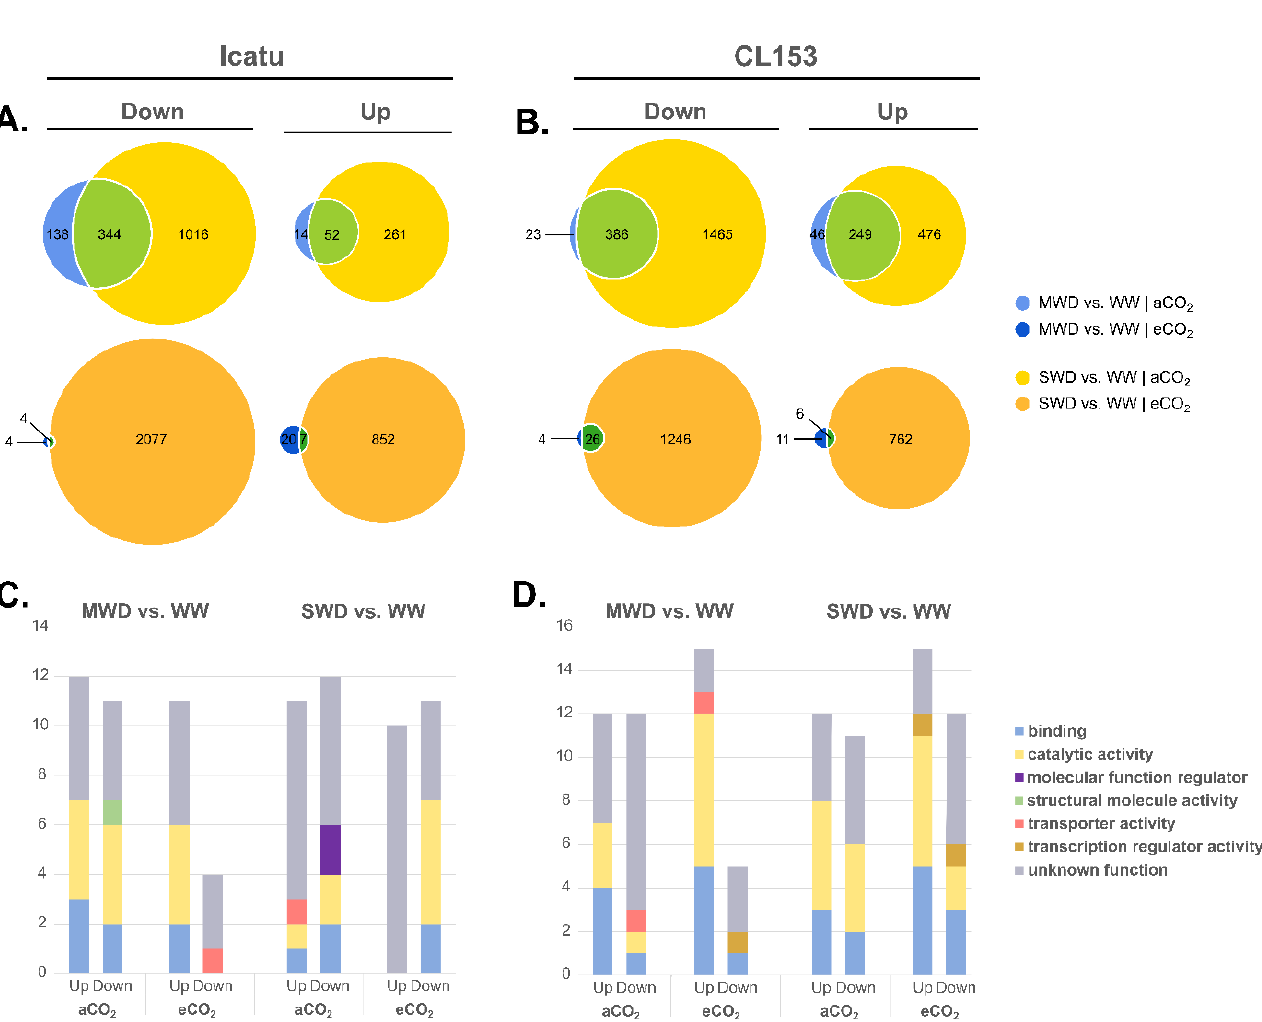
Figure 2. Patterns of differentially expressed genes (DEGs) at MWD or SWD in comparison with WW in ( A ) Icatu and ( B ) CL153 plants grown under either aCO 2 (light colors) or eCO 2 (dark colors), at 25/20 °C (day/night). Blue: DEGs specifically found under MWD. Yellow: DEGs specifically found under SWD. Green: DEGs expressed by both water conditions. Gene ontology (GO) terms found among the top up- and down-regulated differentially expressed genes (DEGs) in ( C ) Icatu and ( D ) CL153 plants. GO terms were selected according to UniProtKB and QuickGO databases. The harshest drought level triggered a high down-regulation of DEGs, in the two genotypes, independently of [CO 2 ] levels (Figure 2A,B; Table S3). The strong impact of the SWD was also depicted on heatmaps visualizing the expression profile of all significant DEGs, where a high degree of variation was found under this harsher drought level in contrast with MWD, which promoted only minor effects (Figure S2). The full list of DEGs can be found in Tables S4 and